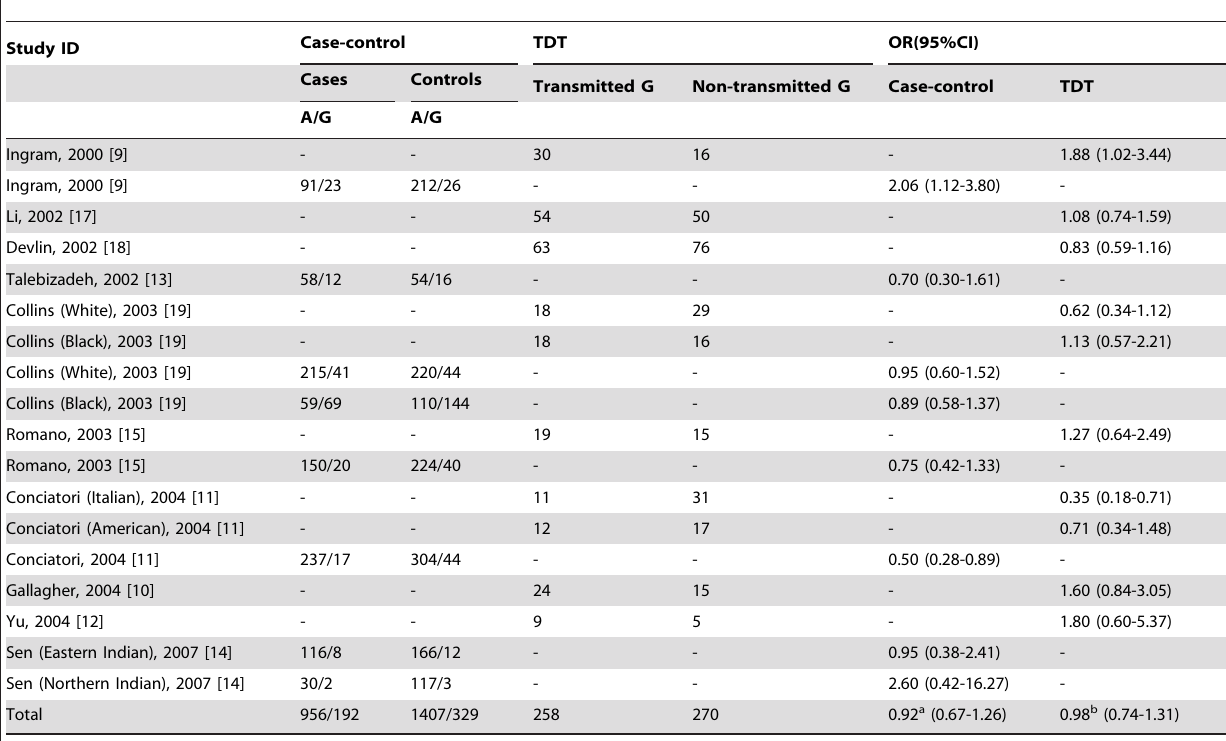
Table 2. Meta-analysis of case-control and TDT studies between the A218G in HOXA1 and ASD.